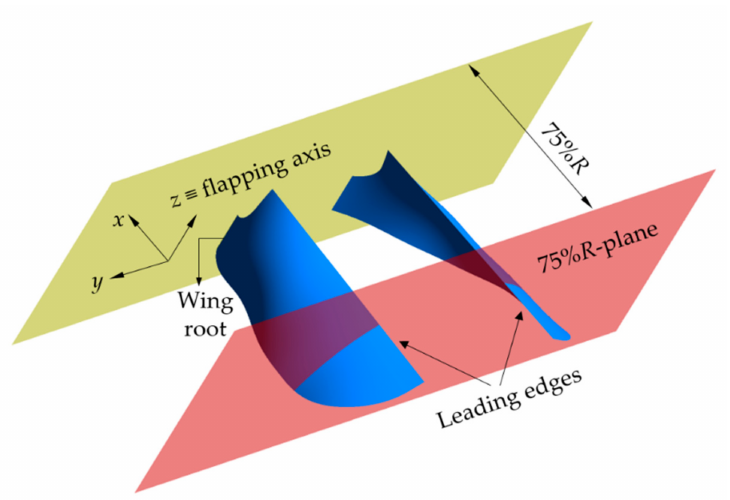
Figure 18. Definition of 75% R -plane (red plane).